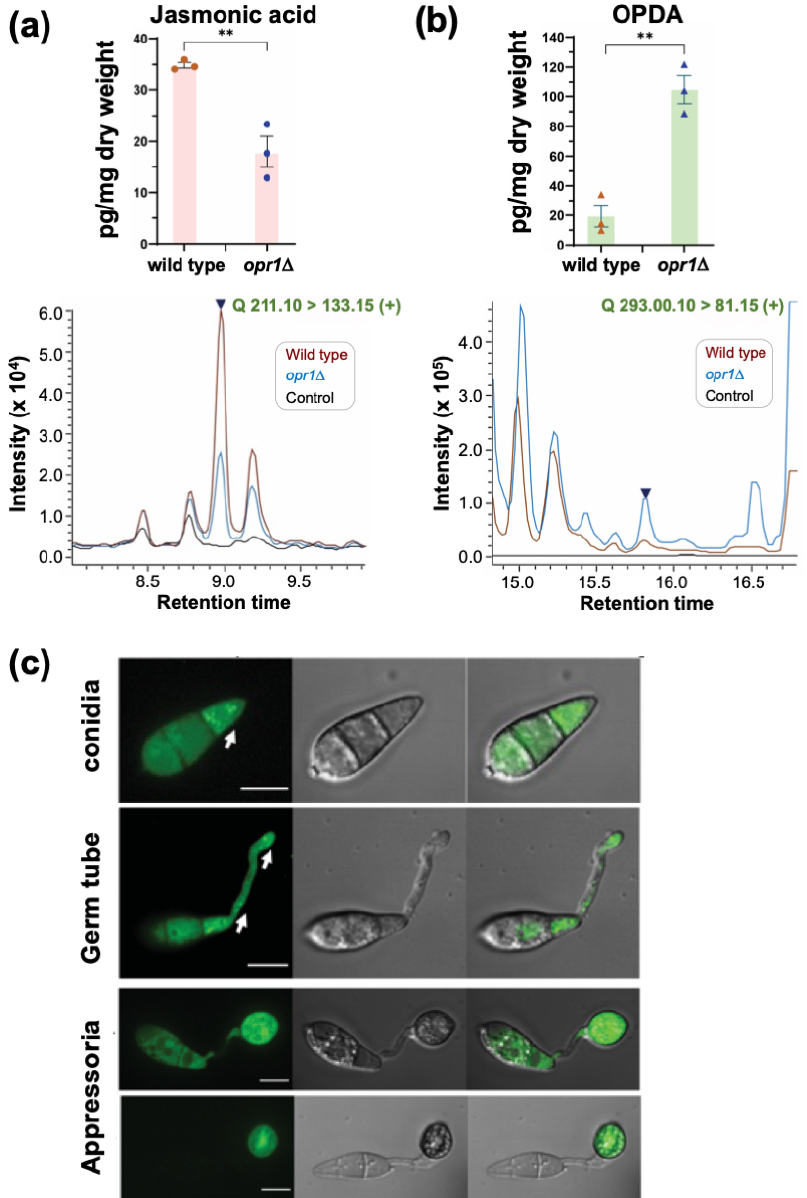
Figure 3. Opr1 is necessary for jasmonate biosynthesis and localizes to a distinct vesicular compartment during pathogenesis in M. oryzae . ( a ) JA production is halved in the oxylipin signature of opr1 Δ compared to the wild type. Selective ion monitoring for the ion m/z = 211.10 was utilised for detection of fungal JA in wild-type (WT) and opr1 Δ . Data are the mean ± SE of three repeats of the experiment. ( b ) A significantly higher accumulation of the substrate of Opr1, cis-OPDA, occurs in the opr1 Δ , while only trace levels of the cis-OPDA are evident in WT extracts. (** p < 0.01; two-sided t -text). The dark blue peak in each spectrum represents the chemical standard used for JA or cis-OPDA, respectively. Please refer to the Methods section for more details. ( c ) Subcellular localization of GFP-Opr1 during pathogenic differentiation in M. oryzae . Conidia from the GFP-OPR1 strain were inoculated on the inductive surface and imaged using confocal microscopy at the developing germ tube, incipient appressorium, and appressorial maturity stages of pathogenesis. Micrographs represent the confocal image for GFP-Opr1 ( left ), brightfield ( middle ) and the merged ( right ) at the indicated stage of development in M. oryzae . Arrows indicate the punctate/vesicular localization of GFP-Opr1. Scale bar = 5 µ